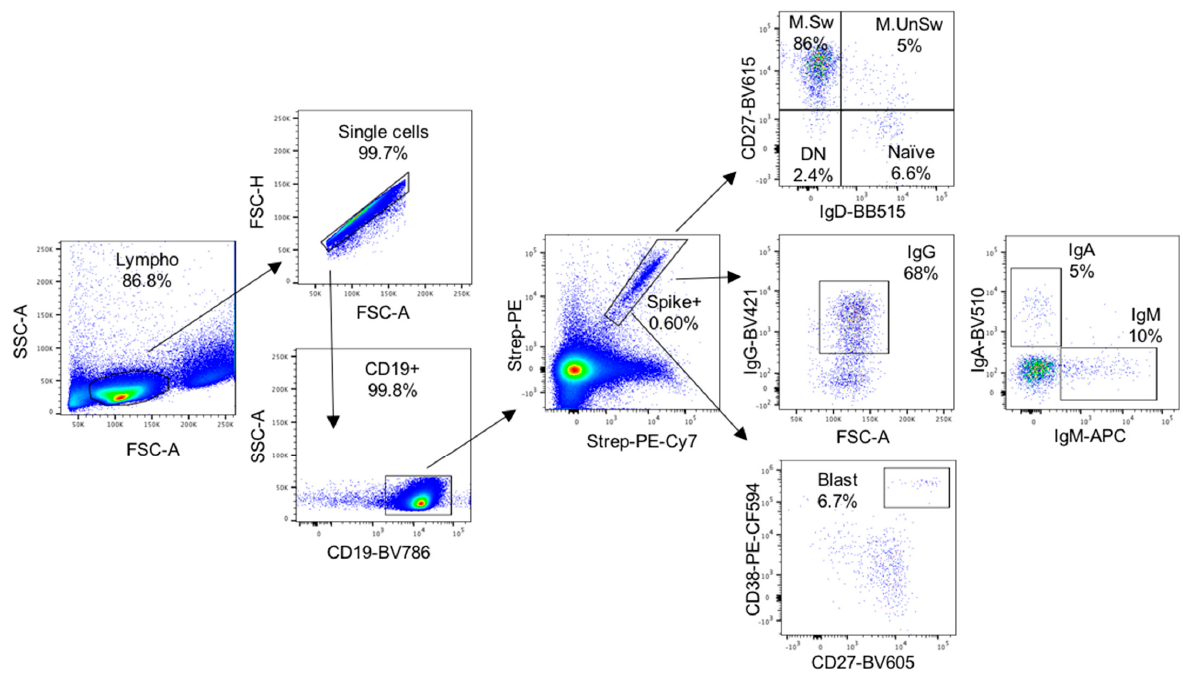
Figure A2. Flow cytometry analysis. Representative gating strategy used to quantify spike-specific B-cell subpopulations.